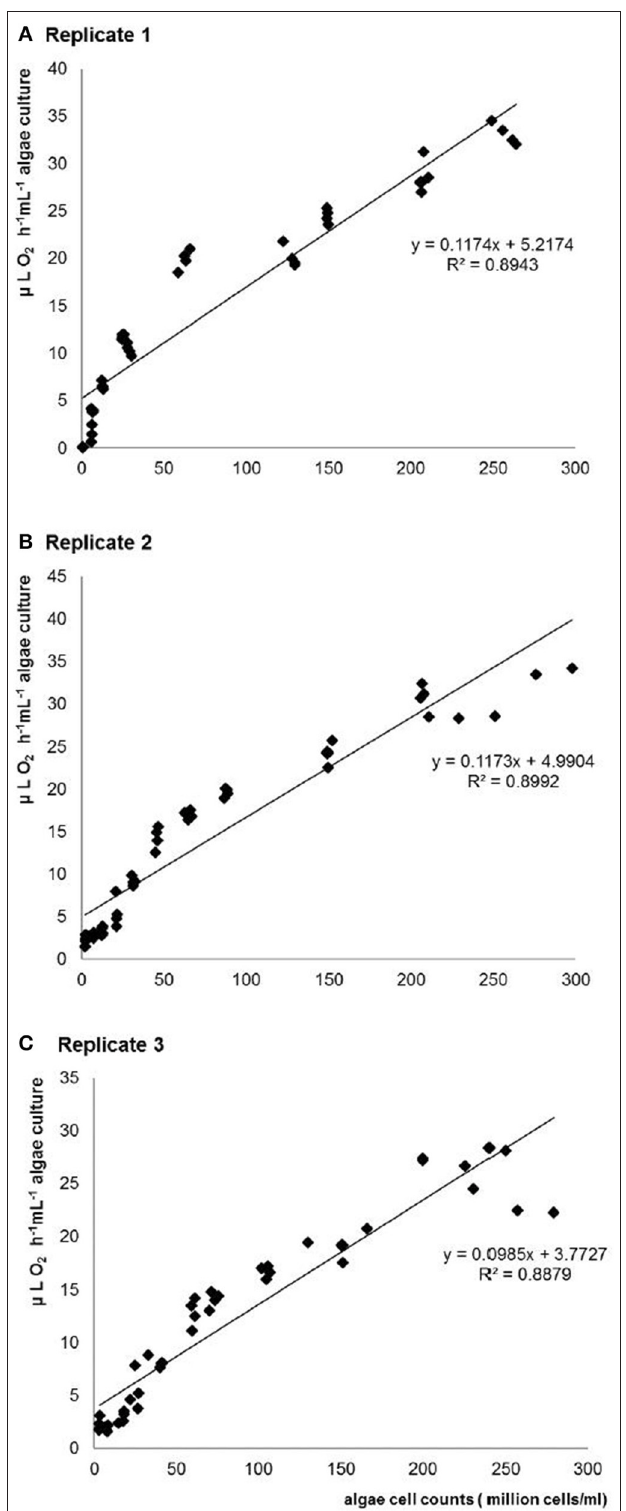
FIGURE 2 | Relationship between light-induced O 2 evolution rate and C. vulgaris cell counts estimated by CASY ® cell counter with 10mL test samples in three repeats. (A-C) replicate 1-3.